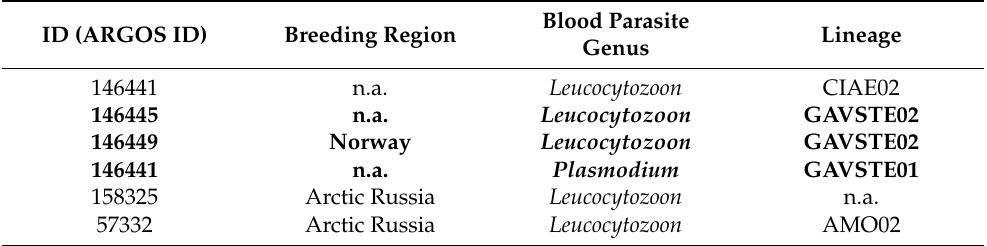
Figure 1. Molecular phylogenetic analysis by Maximum Likelihood Bayesian Analysis, based on parasite DNA sequences (479 bp cyt b fragment). Posterior probabilities of the nodes are shown. Genus names of parasites are indicated in blue, MalAvi lineage names are included in red letters and parasites from red-throated diver samples are given with bird IDs, indicated in black and underlined red. Reference sequences are indicated in black and not underlined. Details of the reference sequences, including blood parasite and host species identity and code and location, are given in Table 2. Table 3. Positively tested blood parasite infections in red-throated divers, with ID (ARGOS-ID/Bird- ID), breeding region, parasite genera and lineage. Novel lineages are indicated in